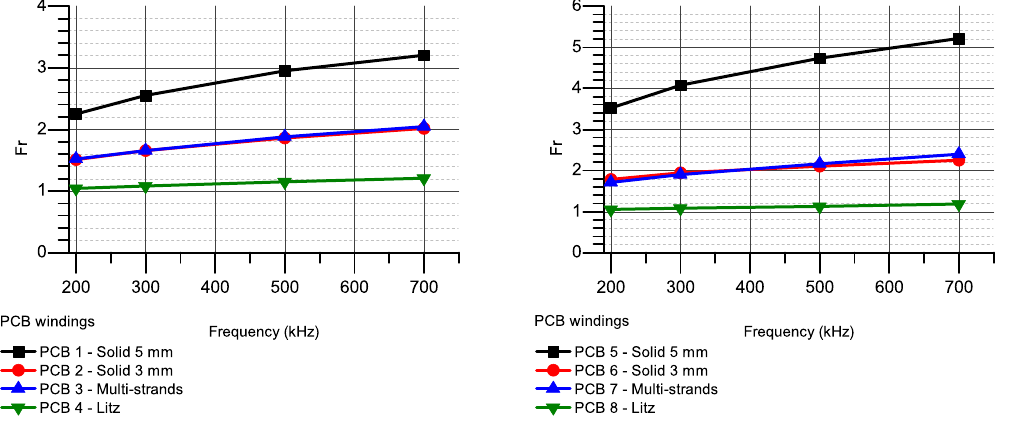
Figure 21. Calculated AC to DC ratio of 3-turn windings ( Left ) and 7-turn windings ( Right ).